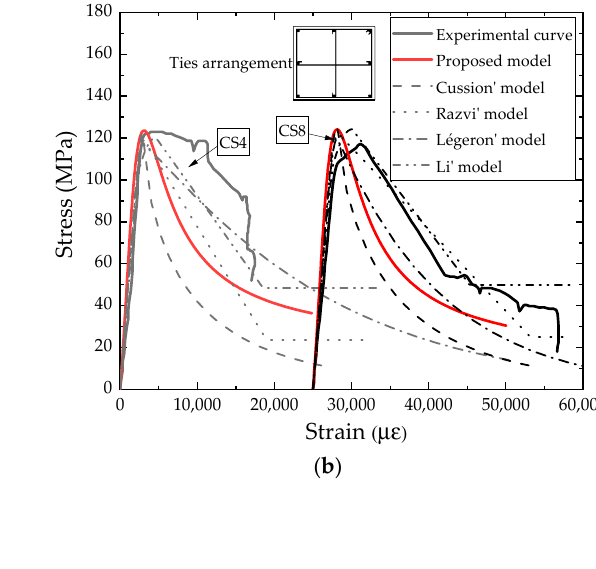
( d ) Figure 18. Comparison of experimental curves and analytical models (Razvi,1999): ( a ) CS-3 and CS- 5; ( b ) CS-4 and CS-8; ( c ) CS-15 and CS-16; ( d ) CS-20. Although there are some di ff erences in the descending portion of the curve, the nor- mal triaxial experimental study of high-strength concrete indicated that the descending portion of the curve has considerable dispersion, and di ff erent test conditions may